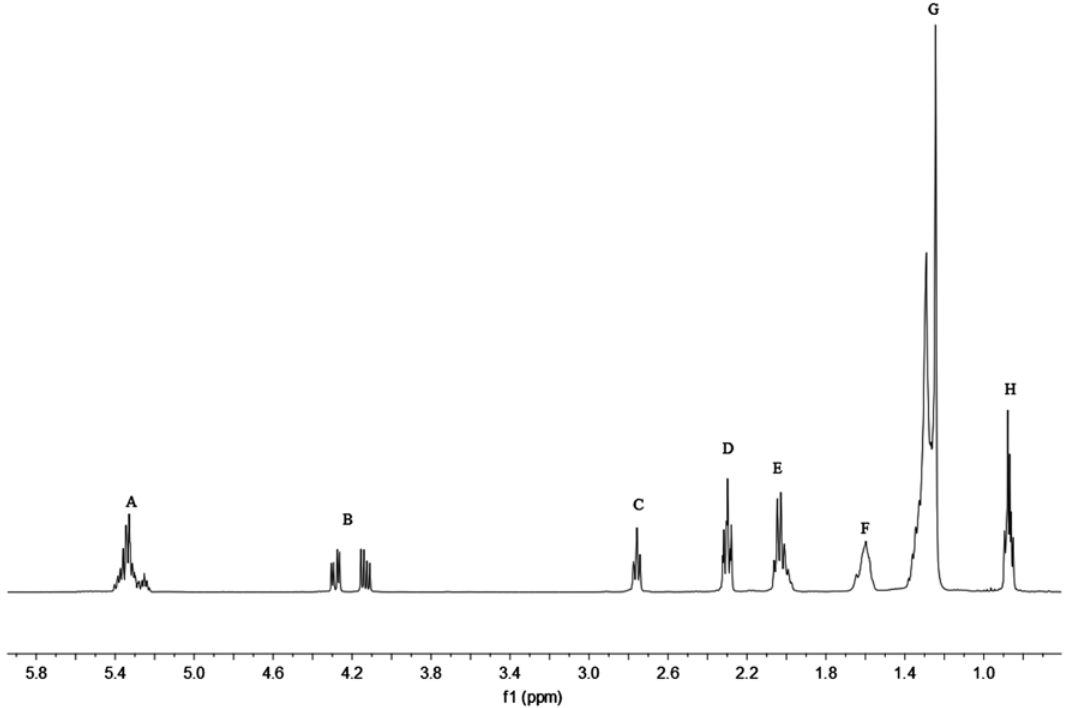
Figure 6: Proton nuclear magnetic resonance ( 1 H-NMR) spectrum of commercial cotton oil used in transesterification reactions. (A) 5.39–5.24 ppm: HC = CH + CH-O; (B) 4.30–4.11 ppm: CH (E) 2.06–1.99 ppm: CH